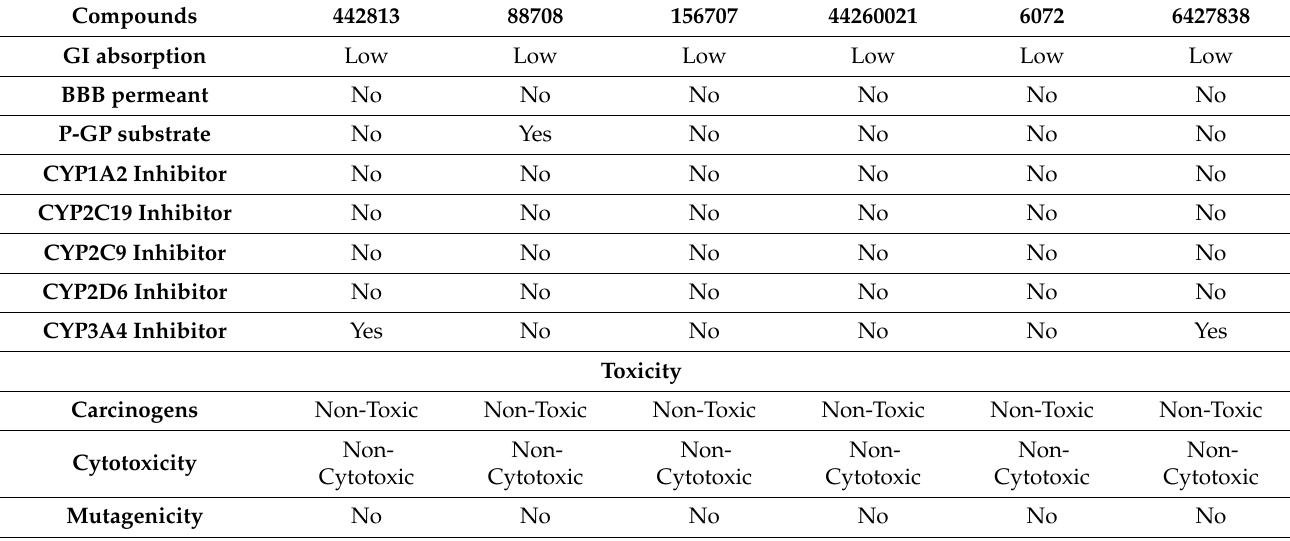
Table 5. The top anticipated drug candidates for the C. pneumonia protein’s pharmacokinetic